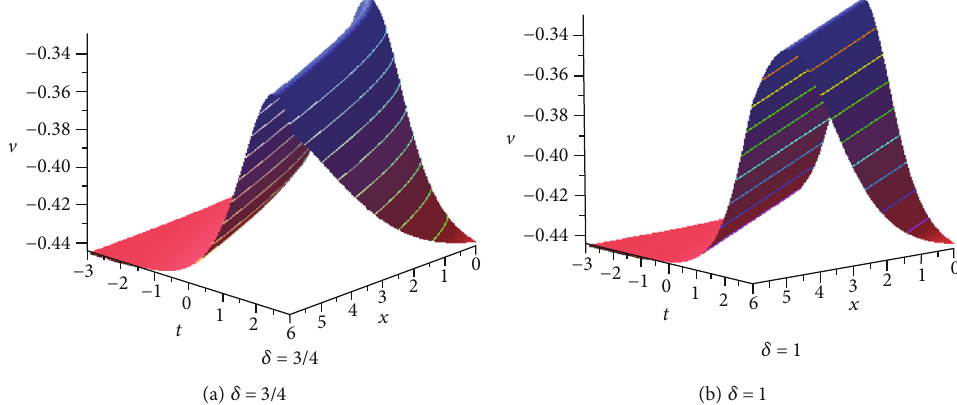
Figure 4: Bright bell wave for l = k = q = h = m